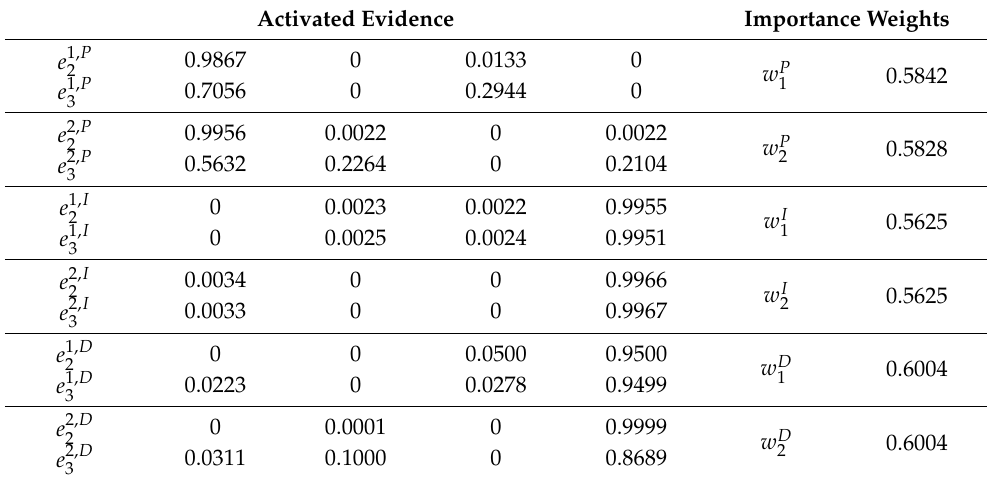
Table 13. Evidence activated at time k = 4 and their corresponding importance weights after optimization. Activated Evidence Importance Weights